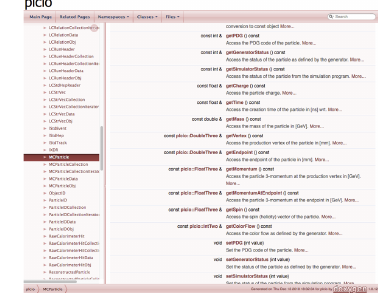
Figure 2. Documentation for the pLCIO classes that implement the complete LCIO event data model. While the interface to access the EDM data classes and their attributes is almost identical to the original LCIO, retrieving collections and handling of meta data is